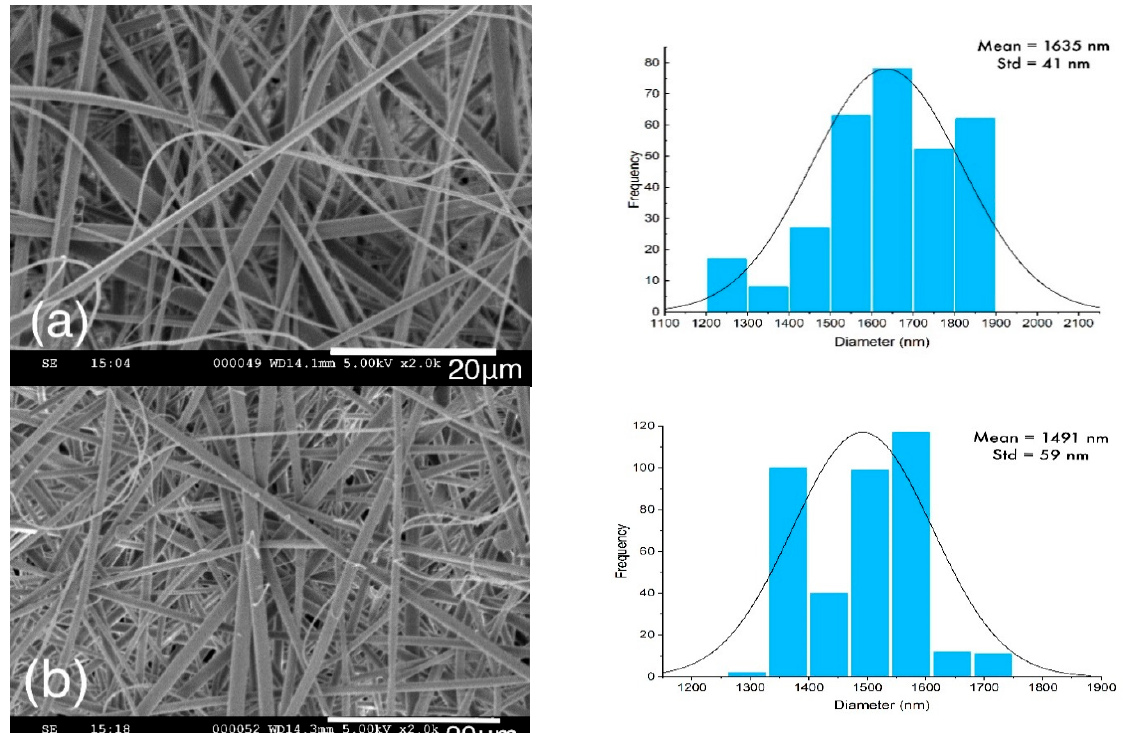
Figure 8. SEM image and diameter distribution of ( a ) lignin and ( b ) lignin/PAMAM 1wt.%, after 5 days.